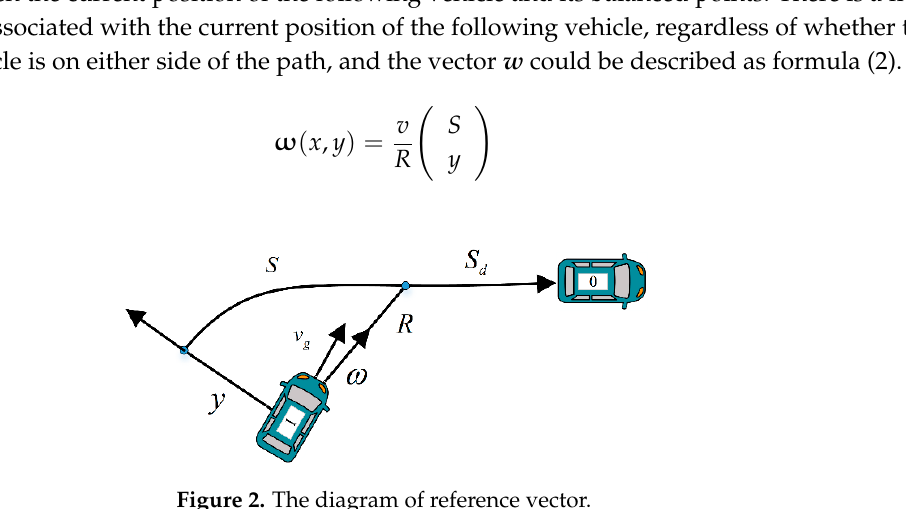
Figure 2 . The diagram of reference vector. Figure 2. The diagram of reference